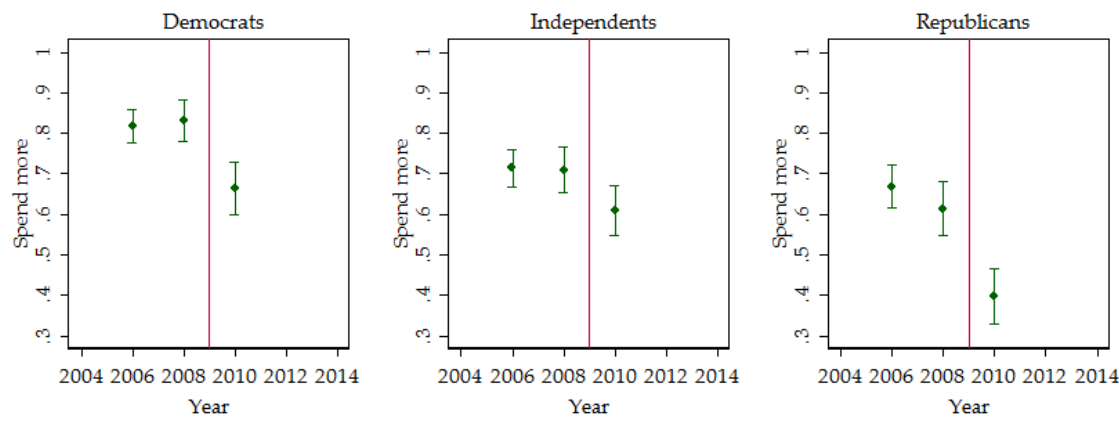
Figure 4: Proportion of respondents, by party identification, who indicate that “too little” money is spent on the nation’s health, for the 2006 Cross-sectional Sample, Re-interviewed in 2008 and 2010